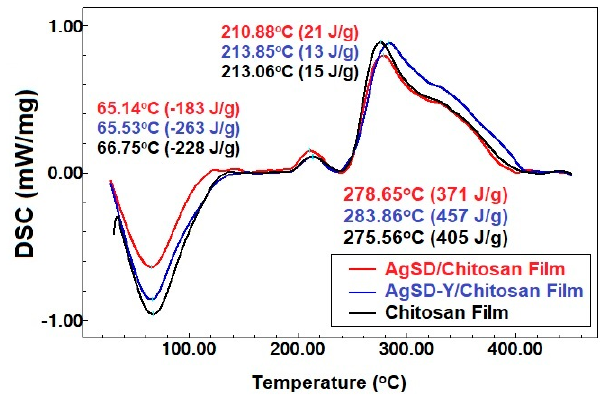
Figure 9. Heating curves of Chitosan films, AgSD / Chitosan film, and AgSD-Y / Chitosan film.